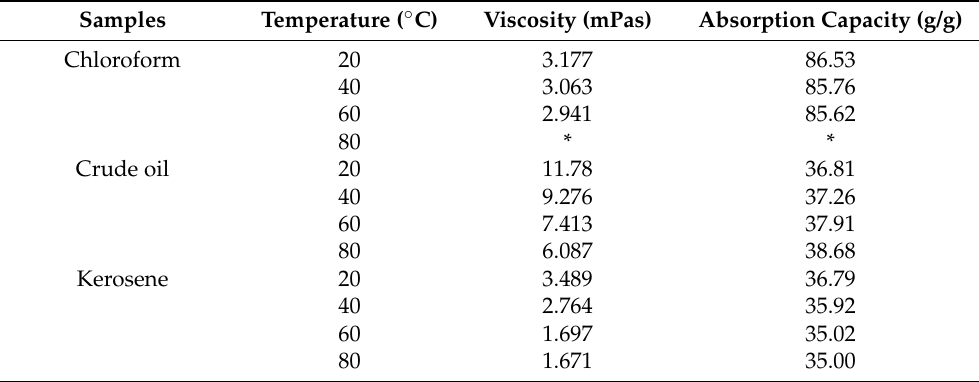
Table 3. Effect of temperature on oil absorption capacity (shear rate was fixed as 1 s − 1 to measure viscosity of the